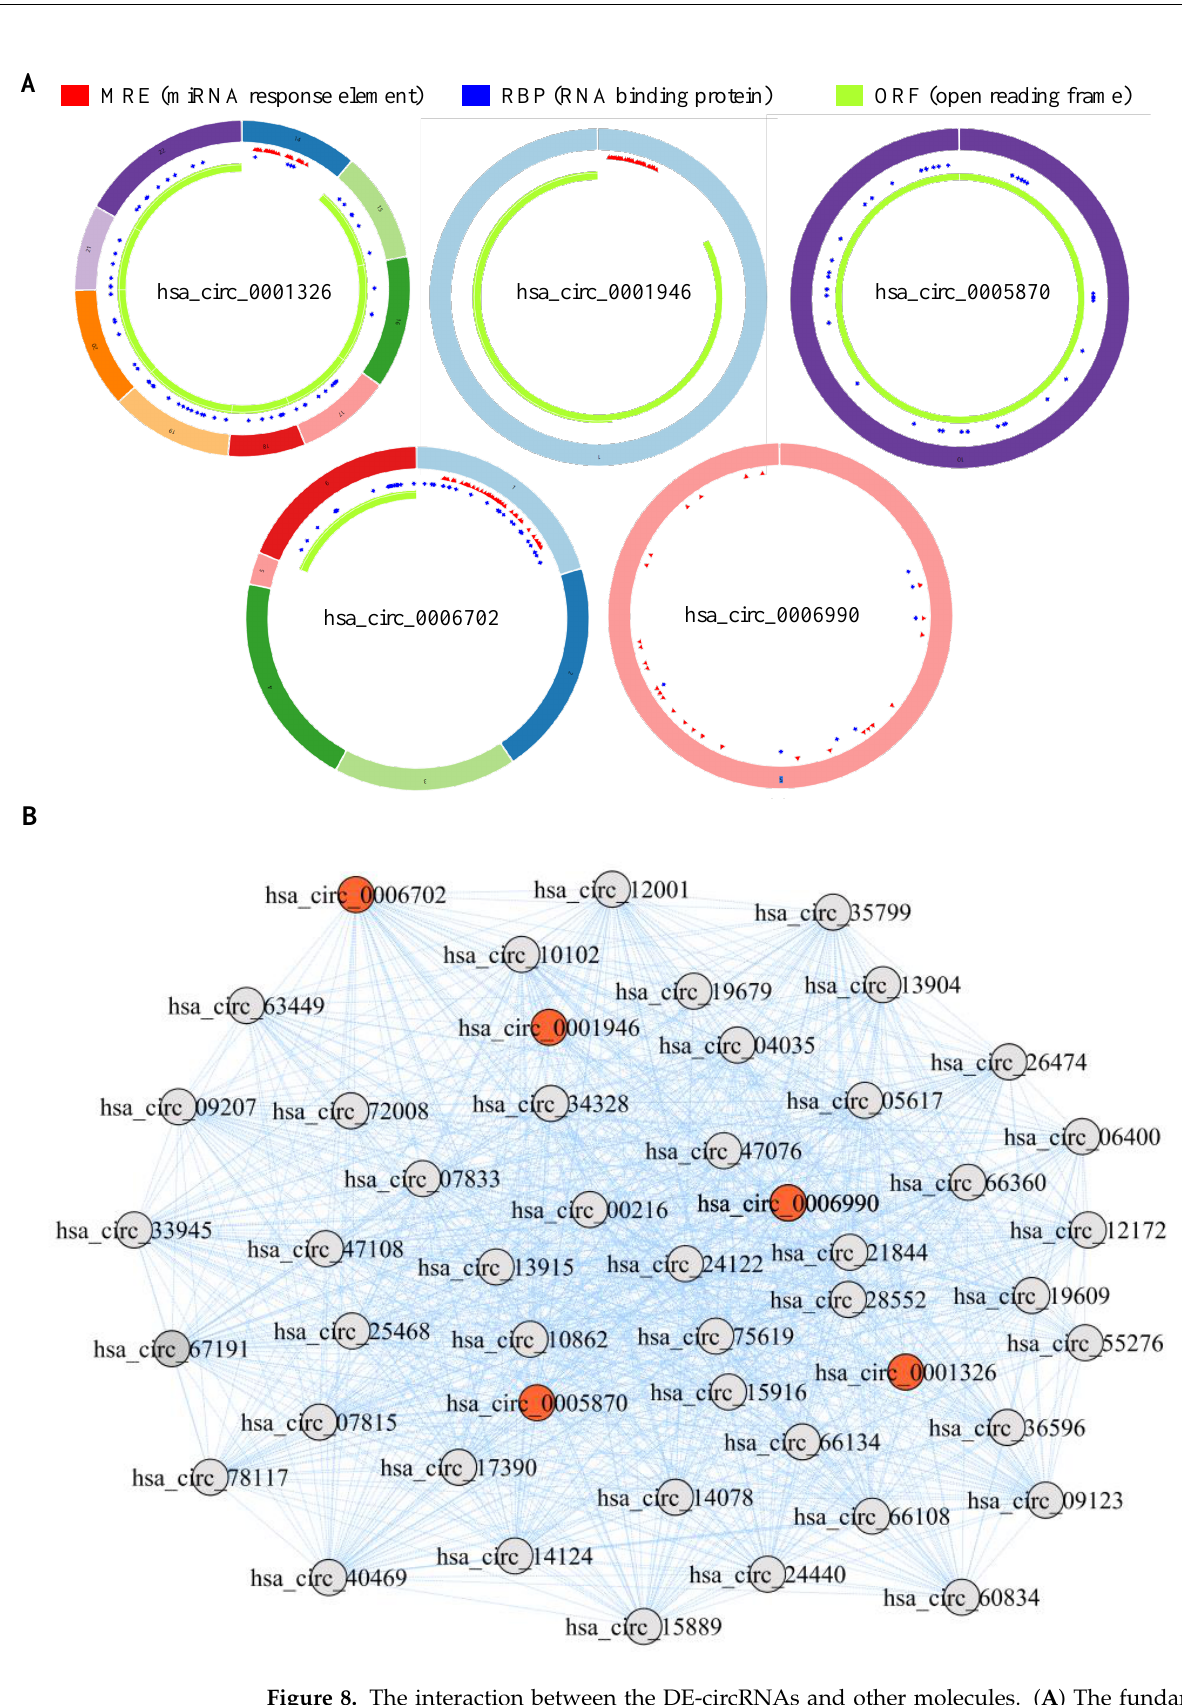
Figure 8. The interaction between the DE-circRNAs and other molecules. ( A ) The fundamental structures of 5 DE-circRNAs are predicted by CSCD. ( B ) RNA regulatory network based on weighted gene co-expression network analysis exhibits the key regulatory functions of 5